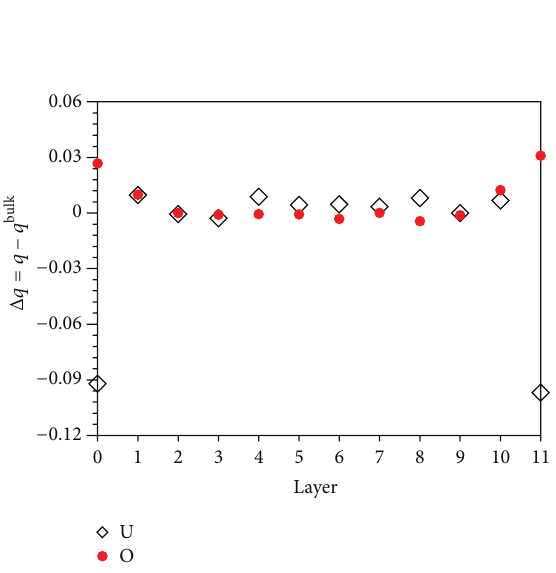
Figure 2: The average difference of Bader charge ( Δ𝑞 = 𝑞−𝑞 bulk ) for U and O between different layer and bulk ( 𝑞 bulk = 2.54 and − 1.27 for U and O,